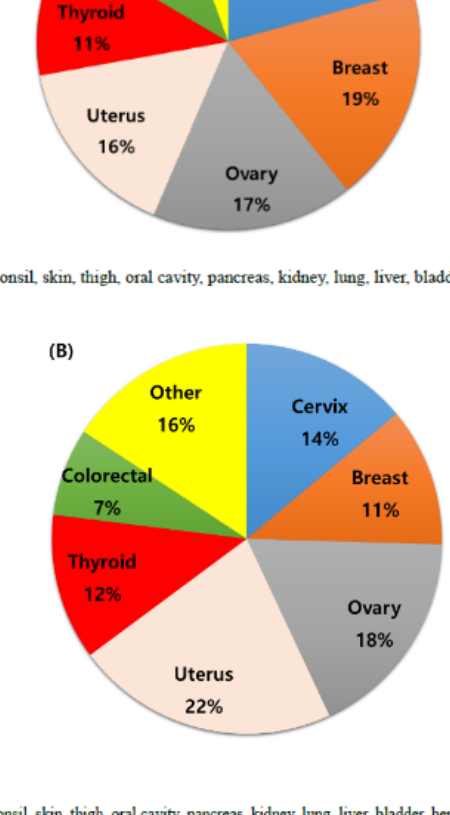
Figure 1. Site distribution of primary cancer. ( A ) First and ( B ) second primary cancers.